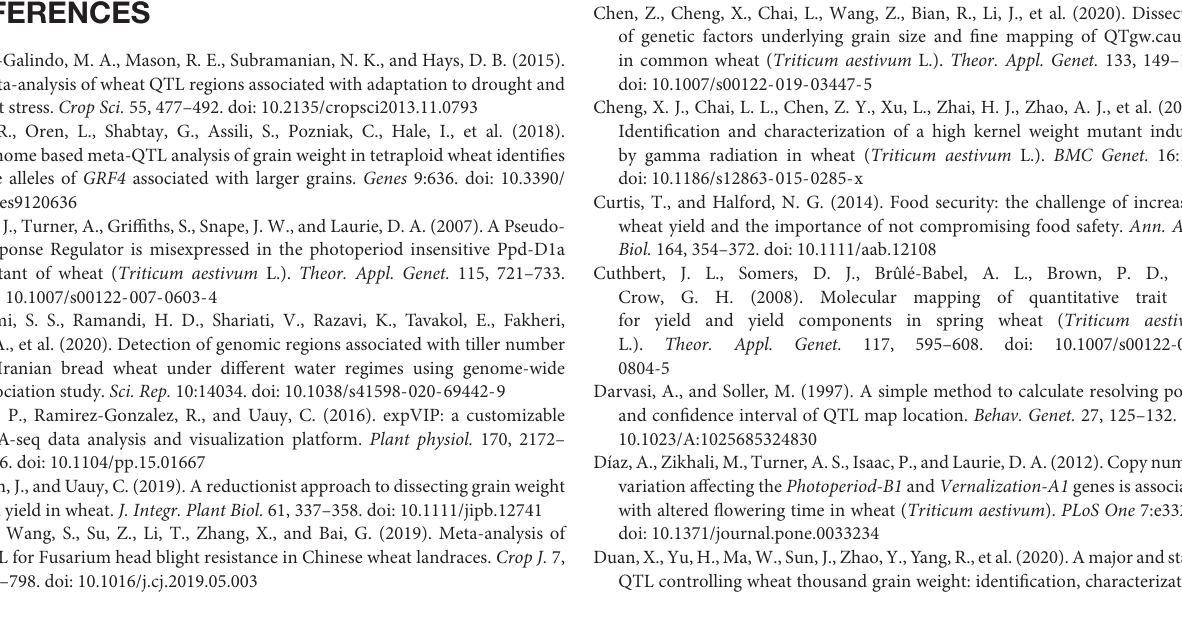
Supplementary Figure 1 | The rainfall for each growing season in the eight tested environments. E1-E6, experimental environments at Yuzhong farm station in six years from 2013 to 2018, respectively; E7 and E8, experimental environments at Tongwei farm station in 2017 and 2018, respectively. Supplementary Figure 2 | Regression analysis for TGW based on annual rainfall. ∗ P < 0.05. Supplementary Figure 3 | Distribution and location of 67 MQTLs on 15 different chromosomes in wheat. The horizontal line on the left of the chromosomes means the successive changes in the phenotypic variance explained (PVE) of individual QTLs and the vertical lines shows the confidence intervals of individual QTLs. And right side on the chromosomes means the markers genetic distance and markers,